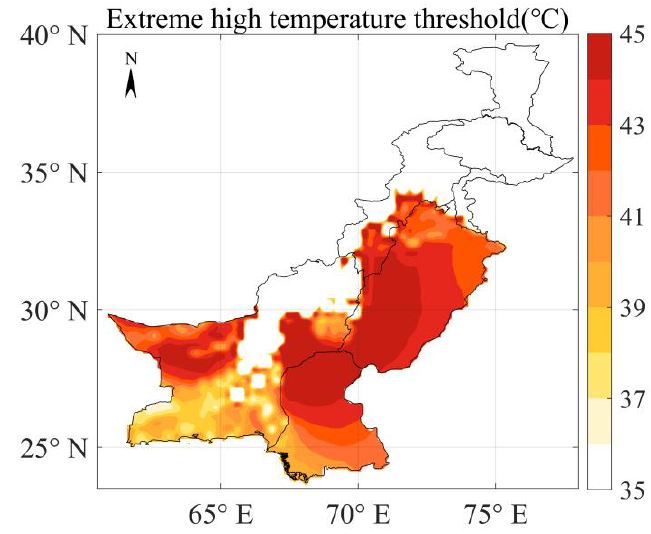
Figure 2. Spatial distribution of extreme high-temperature threshold in CPEC.